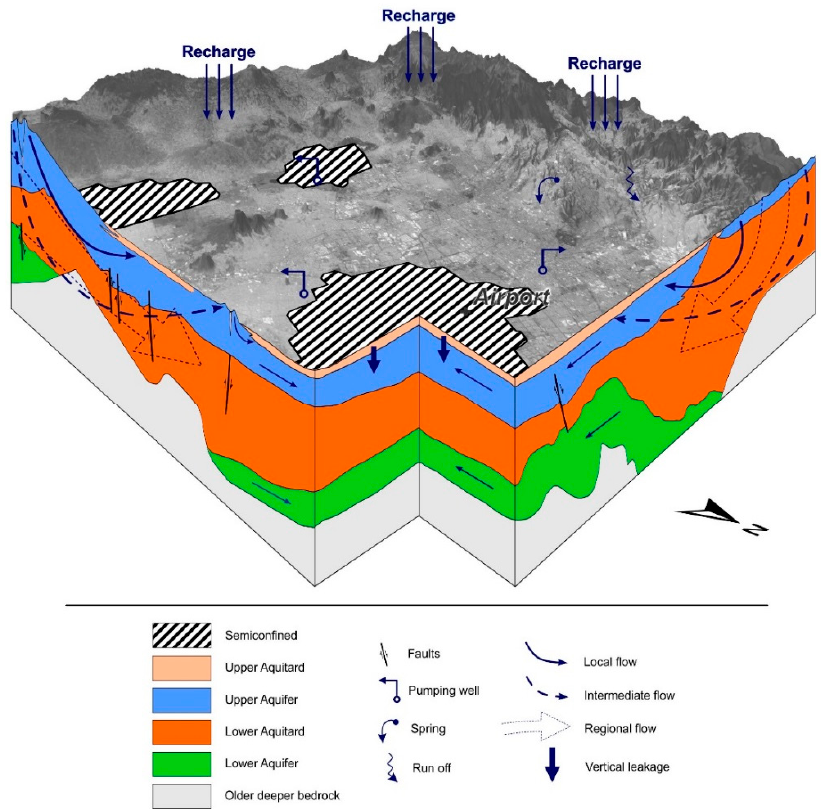
Figure 8. Hydrogeological conceptual model of the Mexico Basin Aquifer based on cross sections C- C’ and D-D’ as shown in Figure